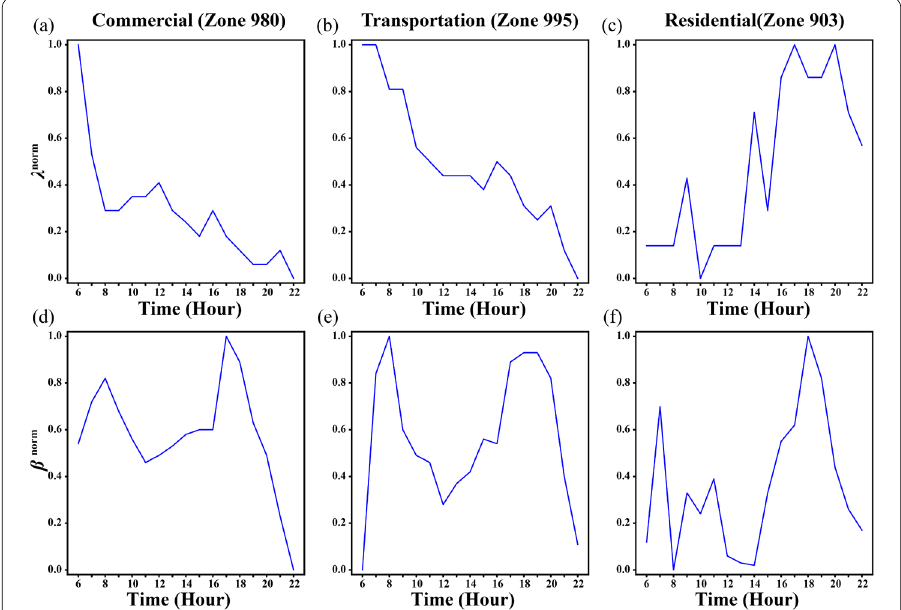
Figure 2 Temporal features of coupling strength λ norm i ( t ) and speed ratio β norm i ( t ). SDNs with destinations at a commercial zone (SDN 1) (panel ( a ), ( d )), a transportation hub zone (SDN 2) (panel ( b ), ( e )) and a residential zone (SDN 3) (panel ( c ), ( f